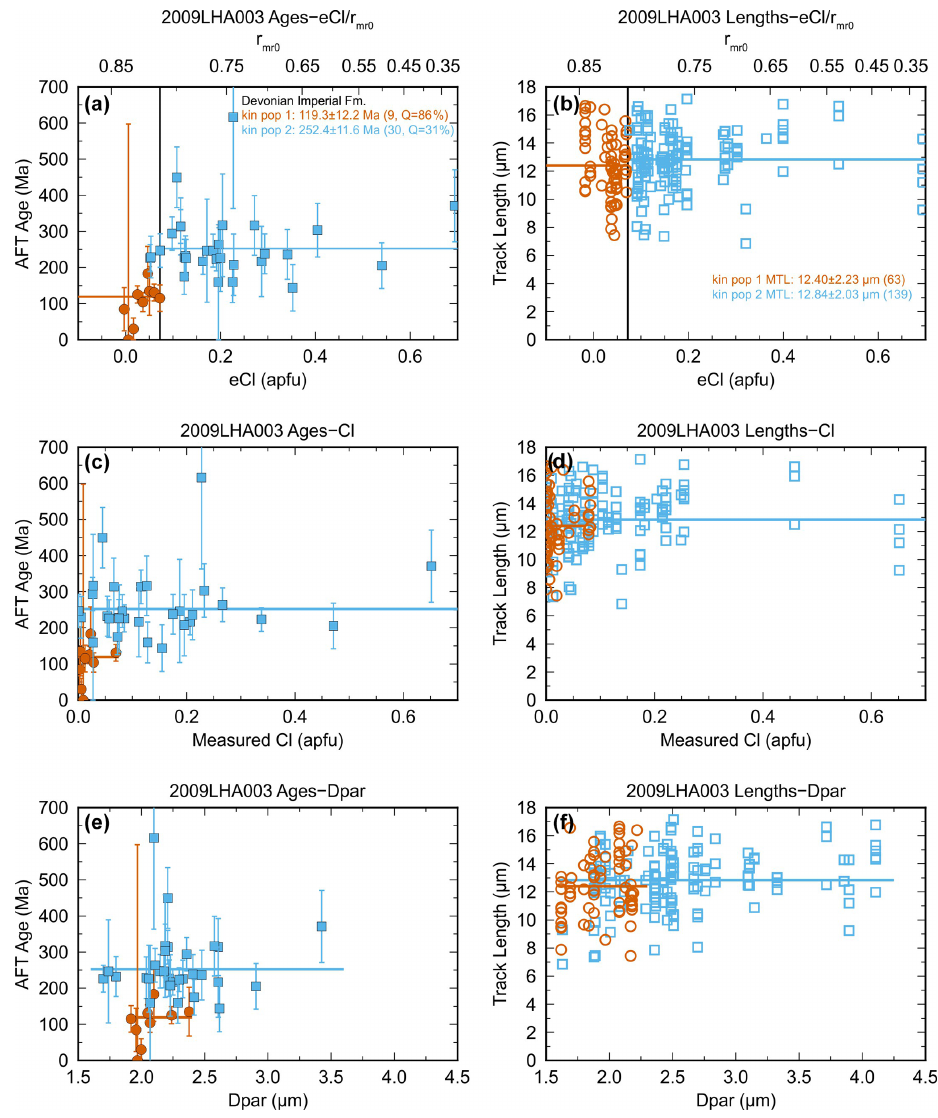
Figure 5. Plots of (a) single-grain ages and (b) track lengths grouped into different coloured-coded kinetic populations using eCl values for the Devonian outcrop sample. The boundary between populations is indicated by the vertical black line. Similar plots of population ages and lengths with respect to Cl concentration (c, d) and D par (e, f) with the same colour scheme as (a) and (b) are also